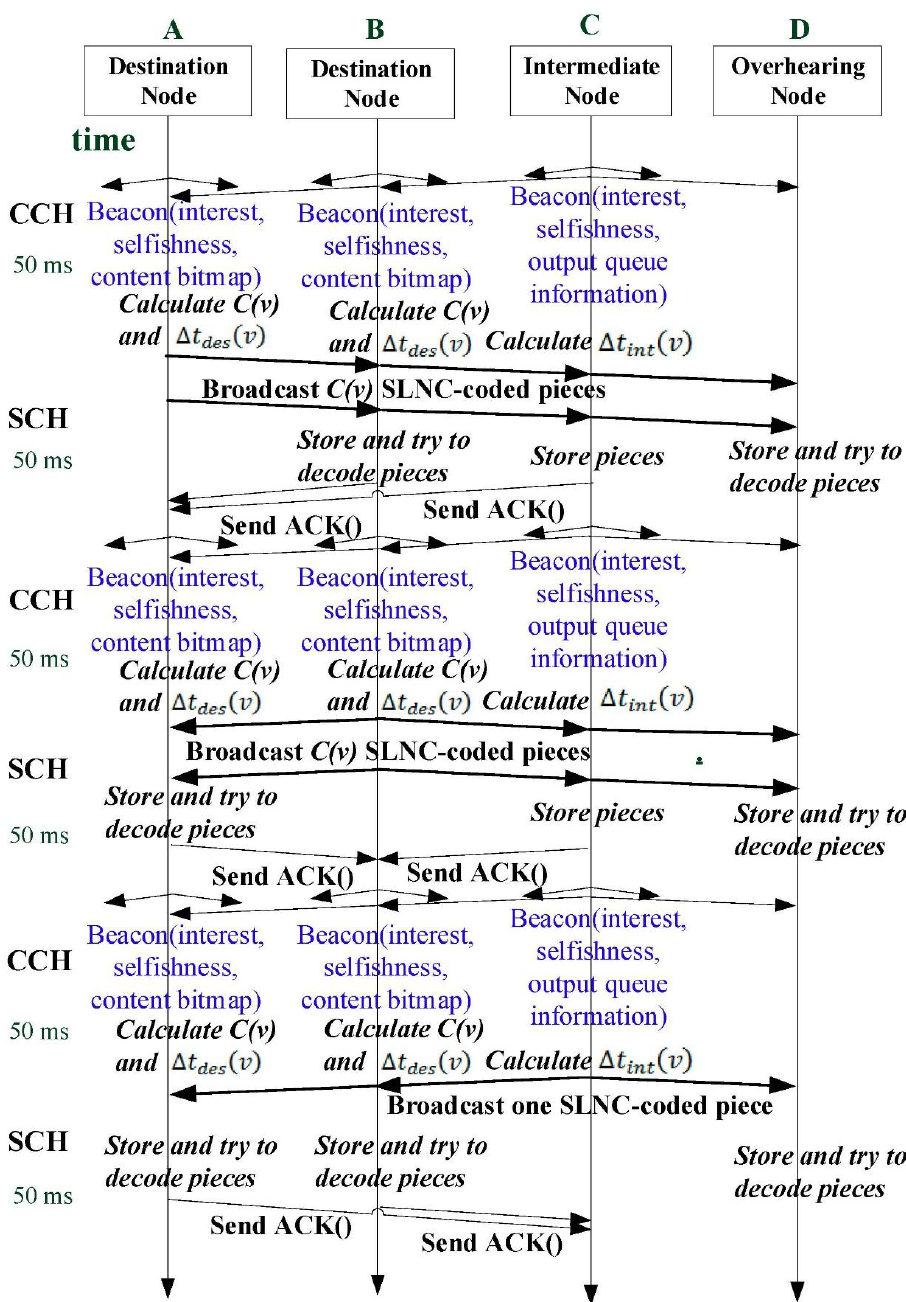
Figure 2. SLNC-based cooperative content distribution flow of SocialCode.